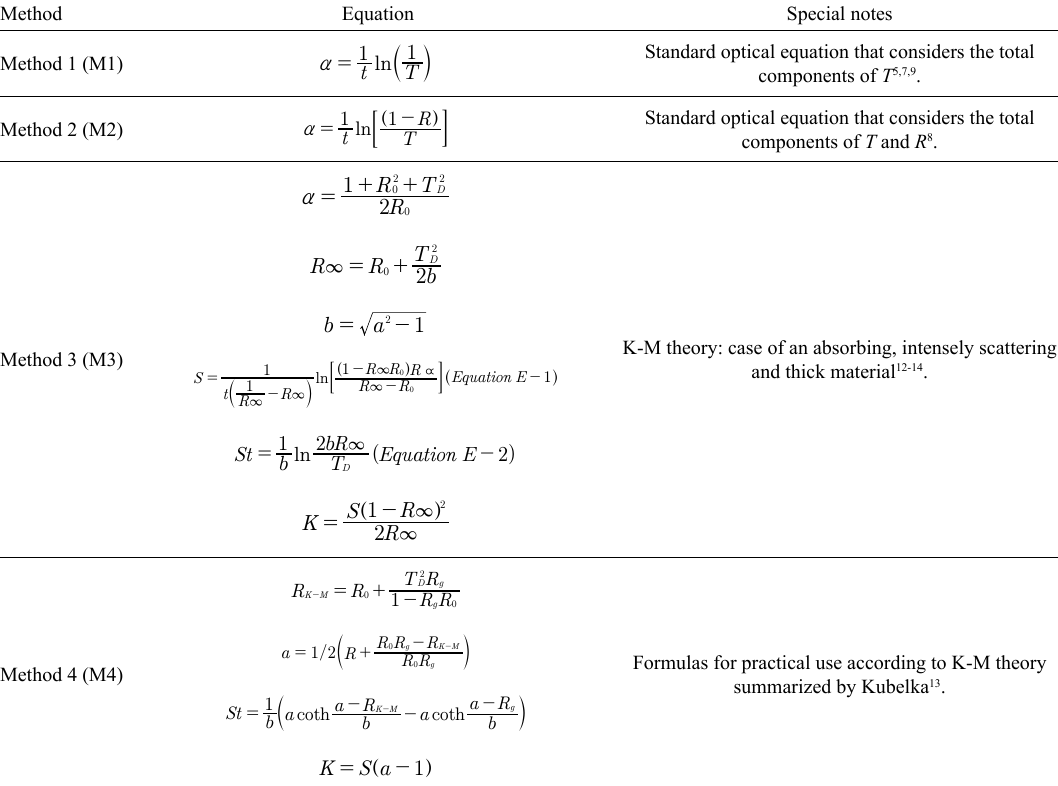
Table 1. Formulas employed for the computation of the absorption coefficient according to several authors. Method